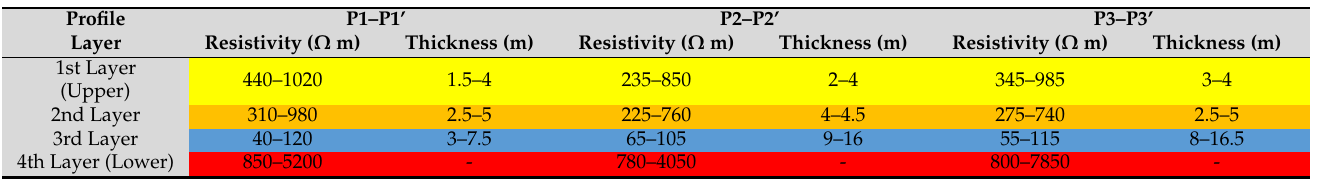
Table 2. Resistivity ( Ω m) and thickness (m) of the subsurface geoelectric layers along Wadi Ranyah pro fi les.